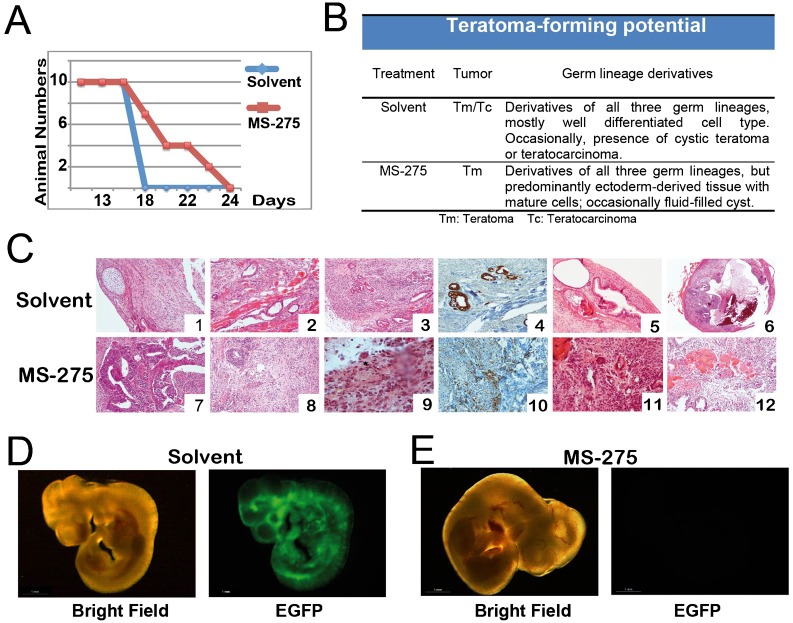
MS-275 in vitro priming impacts both on terato-carcinoma development and content as well as blastocysts colonization in vivo.(A) Teratoma growth rate; x-axis: days of life of each mouse; y-axis: number of mice alive. (B) Post-surgery analysis of teratoma composition. (C) Anatomic/pathologic evaluation. Upper panels: control (ctr); lower panels: lesions obtained in teratomas derived from in vitro 5.0 µM MS-275 pre-treated cells. 1: cartilage and respiratory epithelium; 2: respiratory epithelium and smooth muscle; 3: neuron tubes; 4: immunohistochemistry of pan-cytokeratin, demonstrating the epithelial origin of the structure; 5,6: teratocarcinoma tumor histo-pathological pattern; 7,8: neuron tubes; 9: a mature neuron (see asterisk); 10: immunohistochemistry for GFAP showing glia formation; 11,12: teratoma tumor histopathological pattern. (D,E) Chimera formation assay. Representative photomicrographs (fluorescence/bright field) of the embryos (E11) obtained after blastocyst injection with engineered TBV cell treated with MS-275 (5.0 µM) (E) and solvent (D).